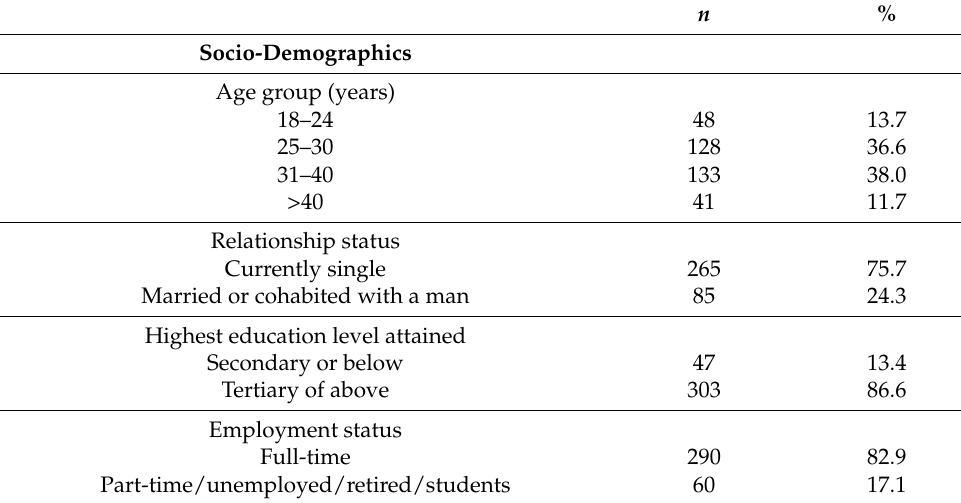
Table 1. Background characteristics of the participants ( n =